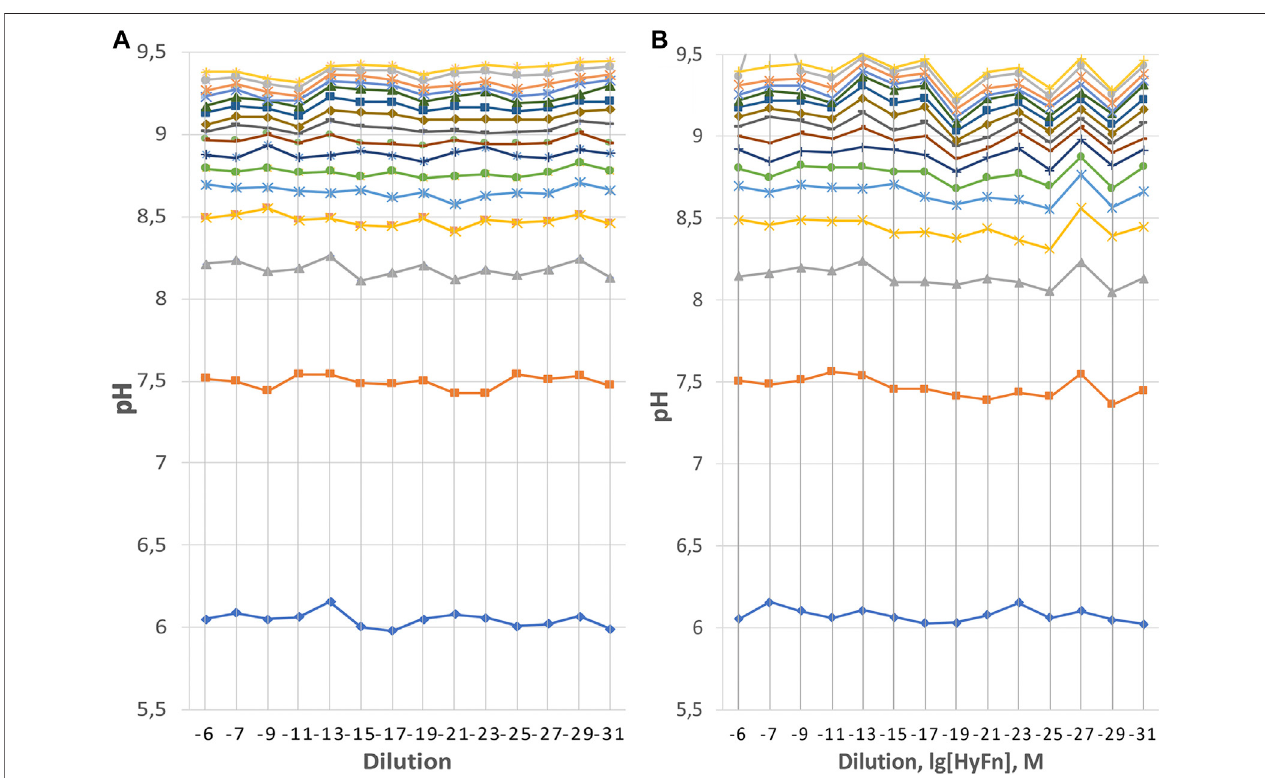
FIGURE5| VariabilityofpHvaluesin (A) “ dilutions ” ofwaterand (B) HyFndilutionsduringsequentialtitrationofsampleswithNaOH.Averagevaluesforalltheseries of samples are presented. Each horizontal line represents pH values in the dilutions after 10 μ L NaOH injections were made. Successive injections are accompanied by increased alkalization, and each next line is higher than the previous one. The lowest lines in (A, B) are pH values in dilutions before the addition of NaOH. Abscissa depicts sequential water “ dilutions ” corresponding to calculated lg [HyFn], M, or of HyFn dilutions.